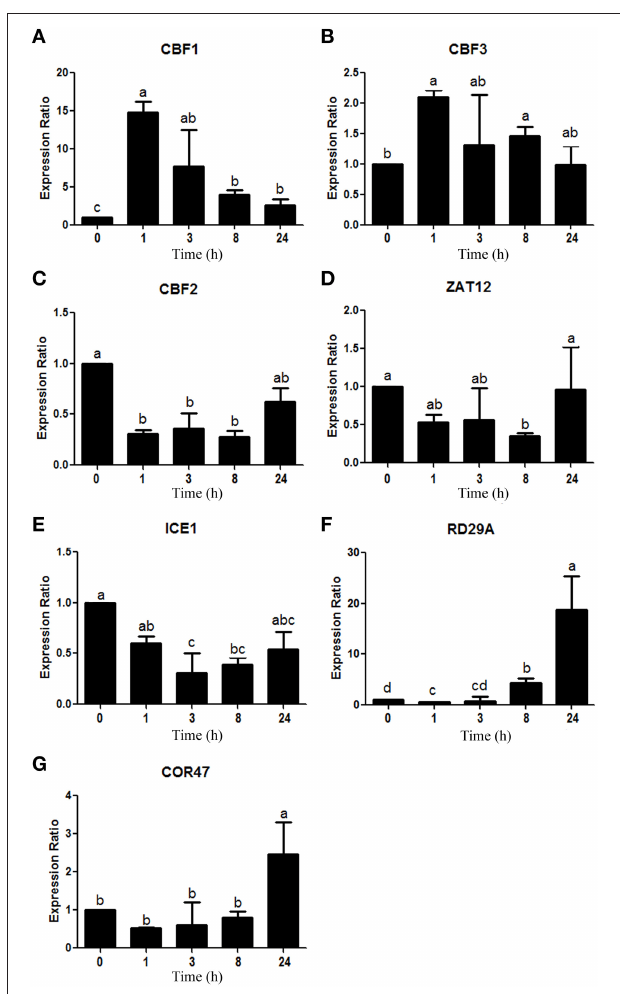
FIGURE 6 | Expression analysis of 7 genes involved in the DREB1/CBF regulon, according to qRT-PCR. Data was obtained at 0, 1, 3, 8, and 24h after cold stress imposition. Expression analysis of the (A) CBF1 ( chr4.CM0126.2110.r2.a) , (B) CBF3 ( chr4.CM0126.2020.r2.a) , (C) CBF2 ( chr5.CM0359.290.r2.m) , (D) ZAT12 ( chr5.CM0180.280.r2.m) , (E) ICE1 ( chr1.CM0104.550.r2.m) , (F) RD29A ( chr5.CM0148.540.r2.m) , and (G) COR47 ( chr1.CM0113.680.r2.d) orthologs. Values represent the mean ( n = 3 ) ± SEM. Means labeled with the same letters do not differ significantly ( p < 0.05 ), while bars indicate standard error of the mean